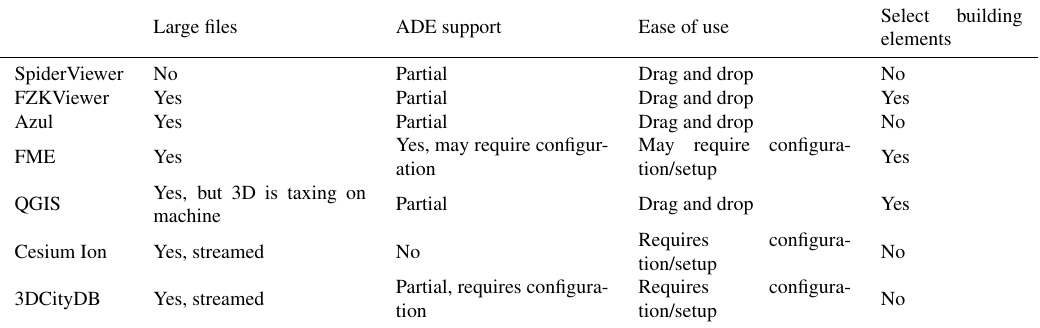
Table 3. Summary of the features supported by the considered software.